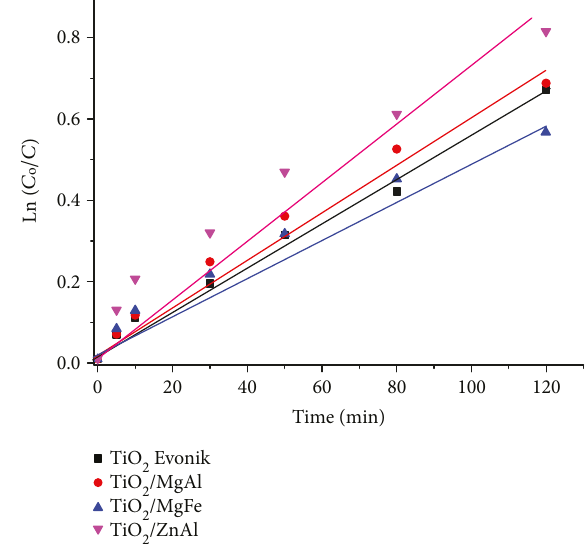
-LDH materials (a) adsorbed and (b) photodegraded. 2